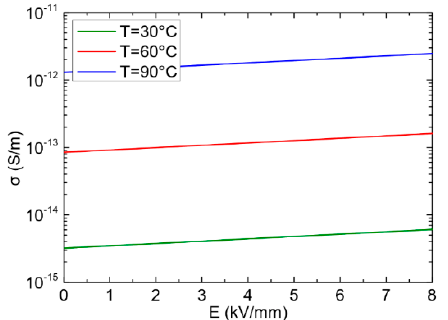
Figure 2. Electric field and temperature dependent conductivity of the standard high-voltage alternating current (HVAC) alumina-filled epoxy.